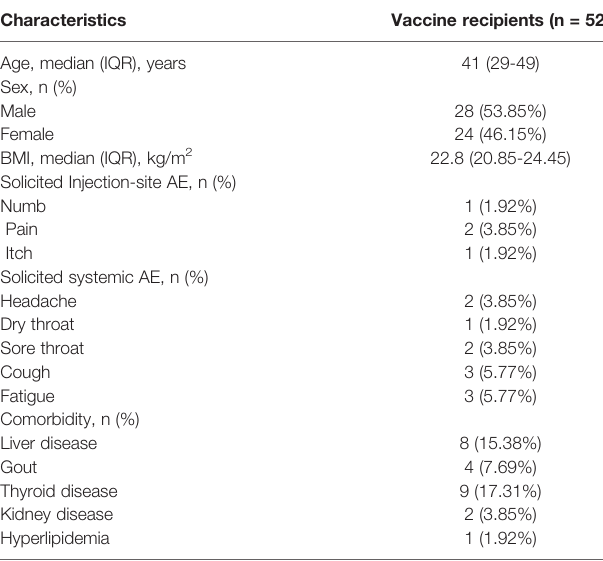
TABLE 1 | Clinical Characteristics of COVID-19 Vaccine Recipients in the Study.